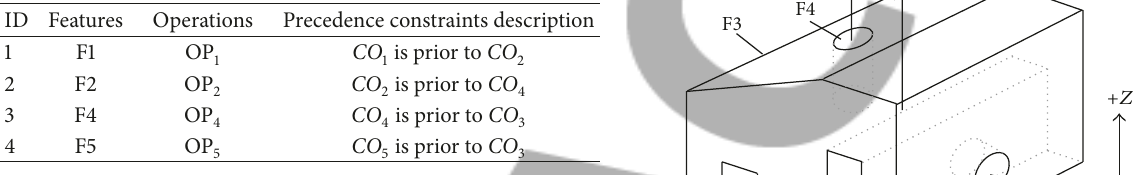
Table 2: Precedence constraints for the example part.